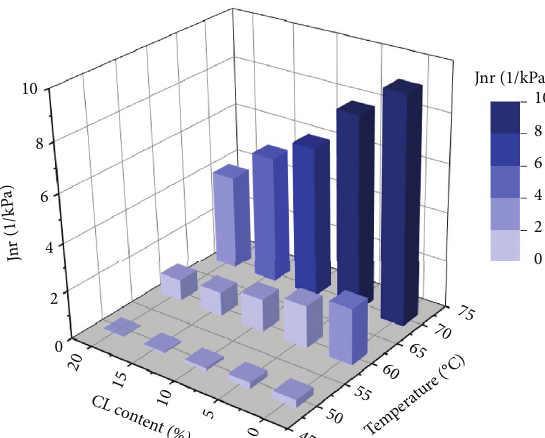
Figure 9: Variations in the nonrecoverable creep compliance ( J